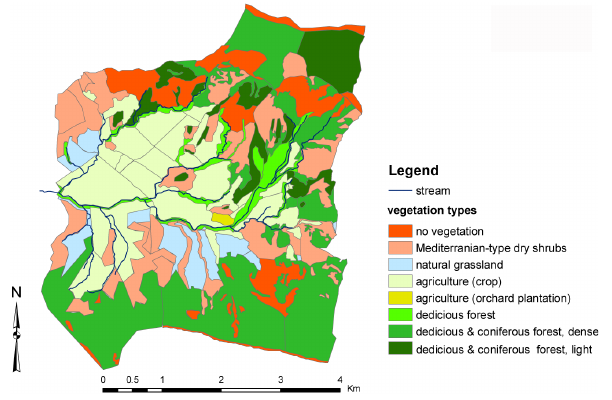
Fig. 4. Geomorphology and GRUs of the